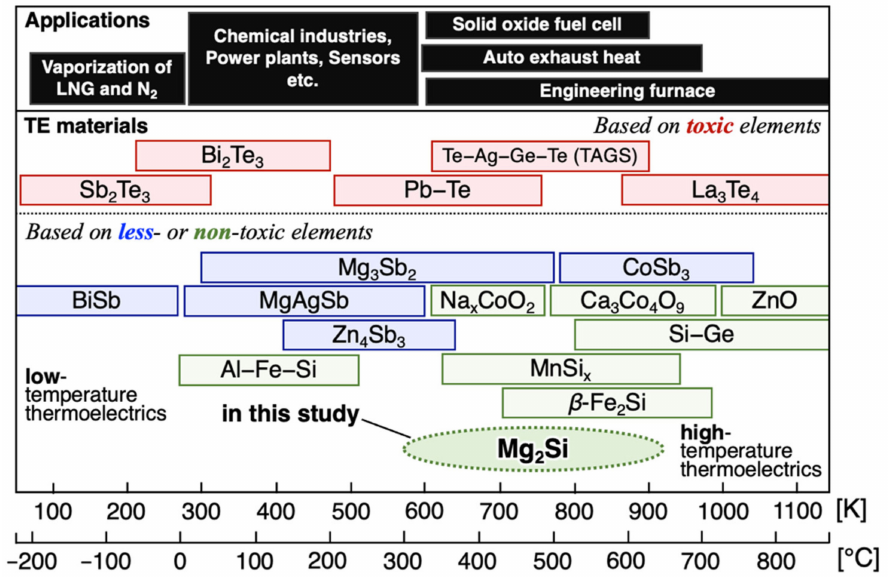
Figure 1. Classification of thermoelectric (TE) materials as a function of operating